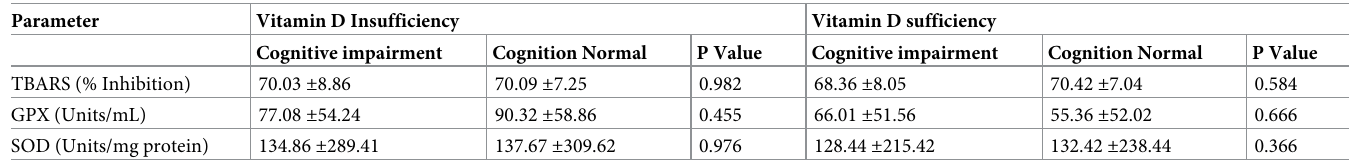
Table 4. Comparison of oxidative markers among diabetic subjects with vitamin D insufficiency and cognitive impairment.